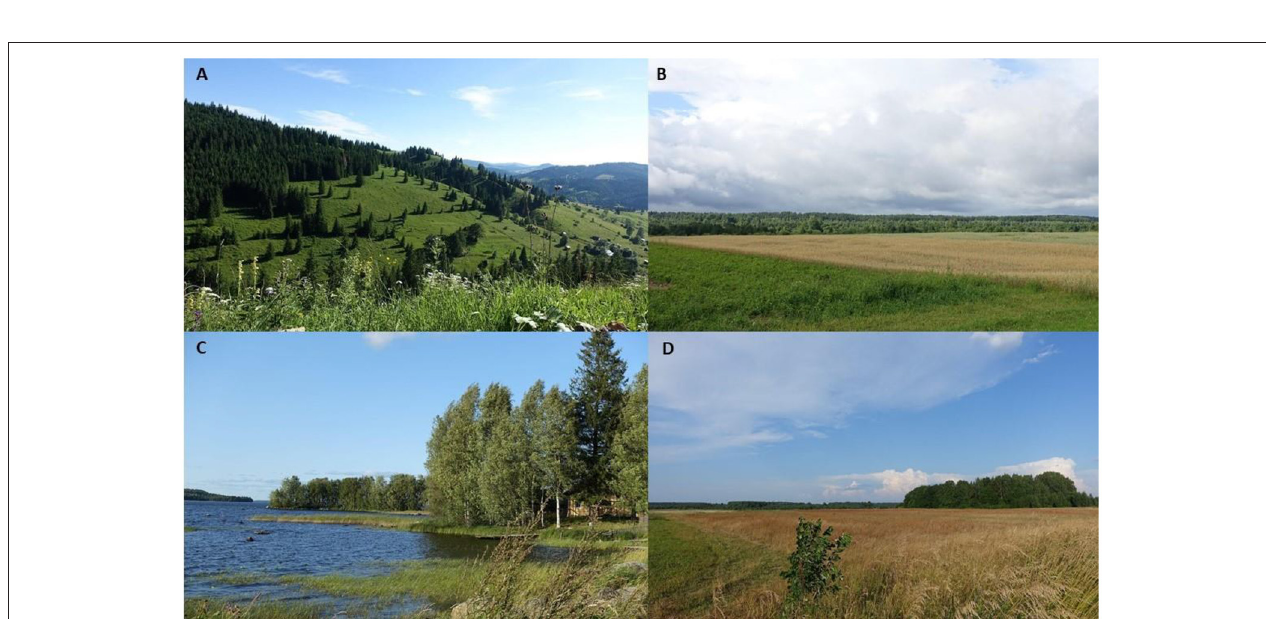
FIGURE 2 | Landscapes of (A) Bukovina, Izvoarele Sucevei (Romania), summer 2019 (credit: Nataliya Stryamets); (B) Dzukija, Tabariškes (Lithuania), summer 2018 (credit: Julia Prakofjewa); (C) Karelia, Essoila (Russia), summer 2018 (credit: Valeria Kolosova); (D) Setomaa Panikovichi (Russia), summer 2018 (credit: Olga